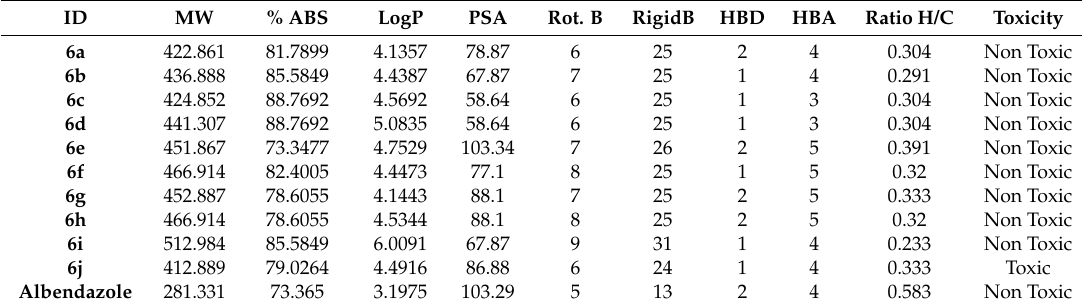
Table 4. The Pharmacokinetic parameters important for agents to have excellent oral bioavailability of synthesized